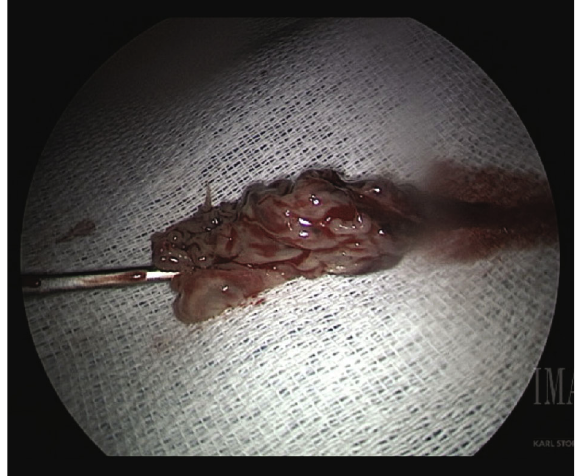
Figure 2: Left atrial vegetation.